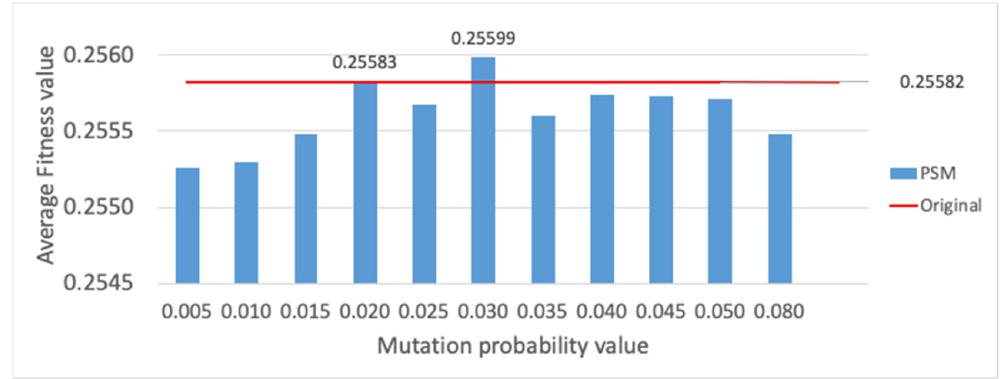
Figure 15. Average fitness value of the best individual for PSM method vs. different mutation probability values.